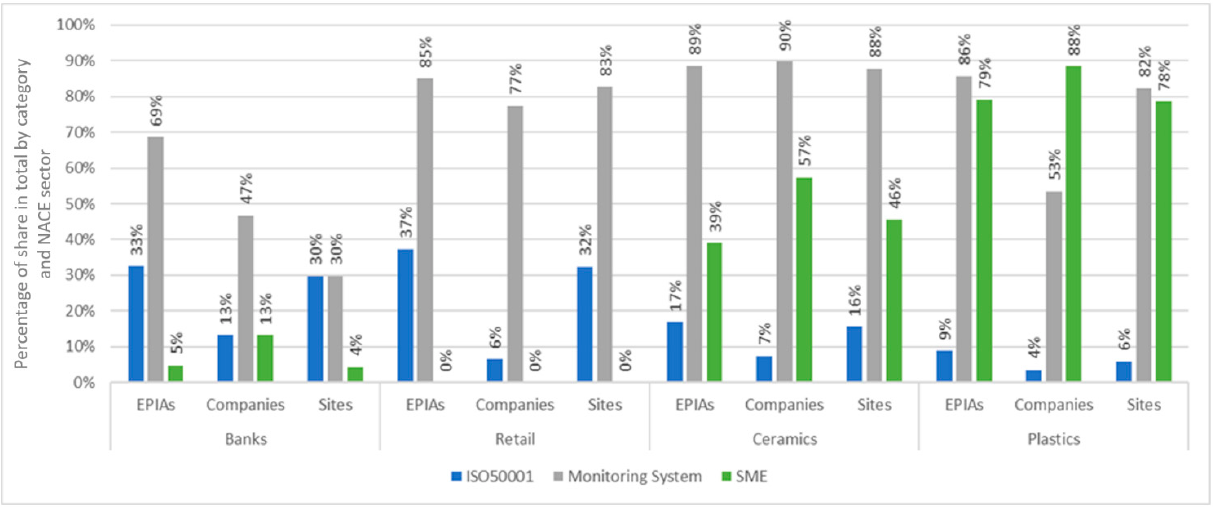
Figure 3. Share in total EPIAs by category.